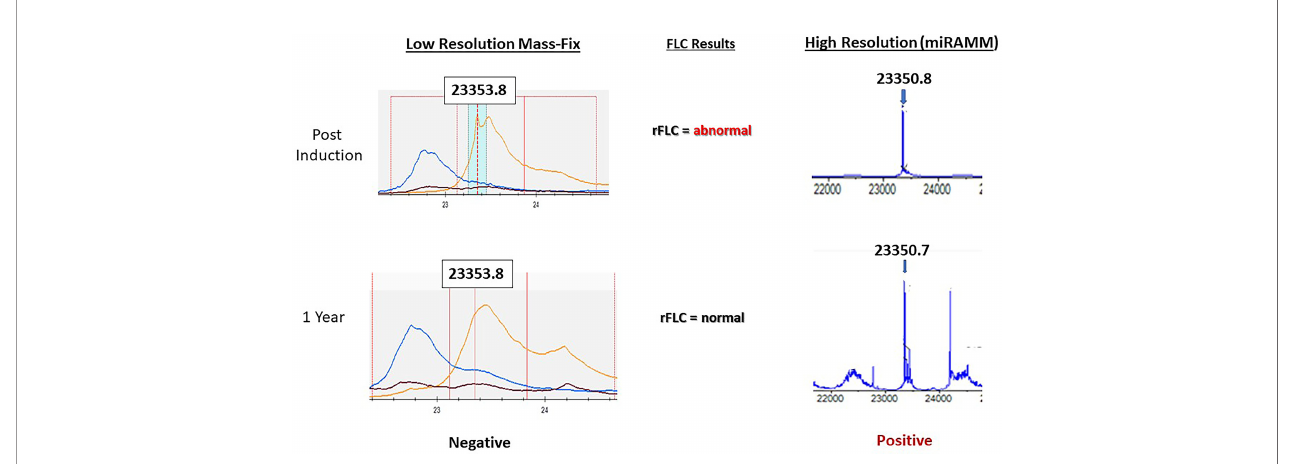
FIGURE 2 | Representative example showcasing the superior sensitivity of the miRAMM approach over MASS-FIX (Mayo Clinic ’ s MALDI-TOF based approach). A patient with monoclonal kappa multiple myeloma early and one year after induction therapy. After the normalization of the free light chains and the free light chain ratio at one year from diagnosis, MASS FIX became negative, whereas miRAMM remained positive. Bone marrow MRD assessment by multicolor fl ow was also positive (not shown) at the time. This example suggests that MALDI-TOF based approaches are less likely to be the answer to MRD assessment using peripheral blood, but more sensitive methods are currently being compared to fl ow cytometry techniques for MRD assessment. Image courtesy of Dr. David Murray, Director, Mayo Clinic Immunology